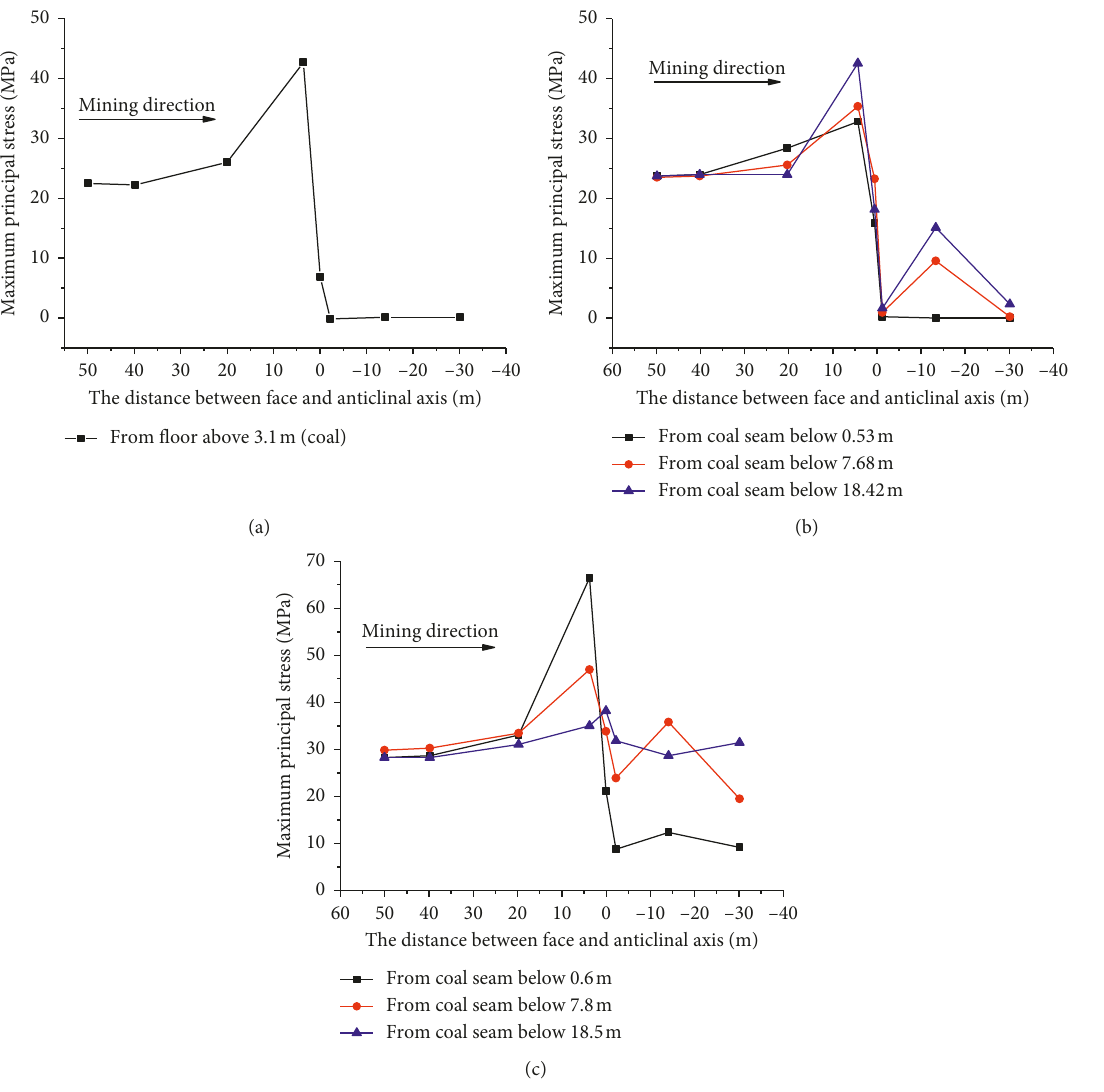
Figure 9: Distribution curves of maximum principal stress of anticlinal axis. (a), (b), and (c). Table 1: Value of “ E E 0 C ” at the peak of abutment pressure with different advancement −